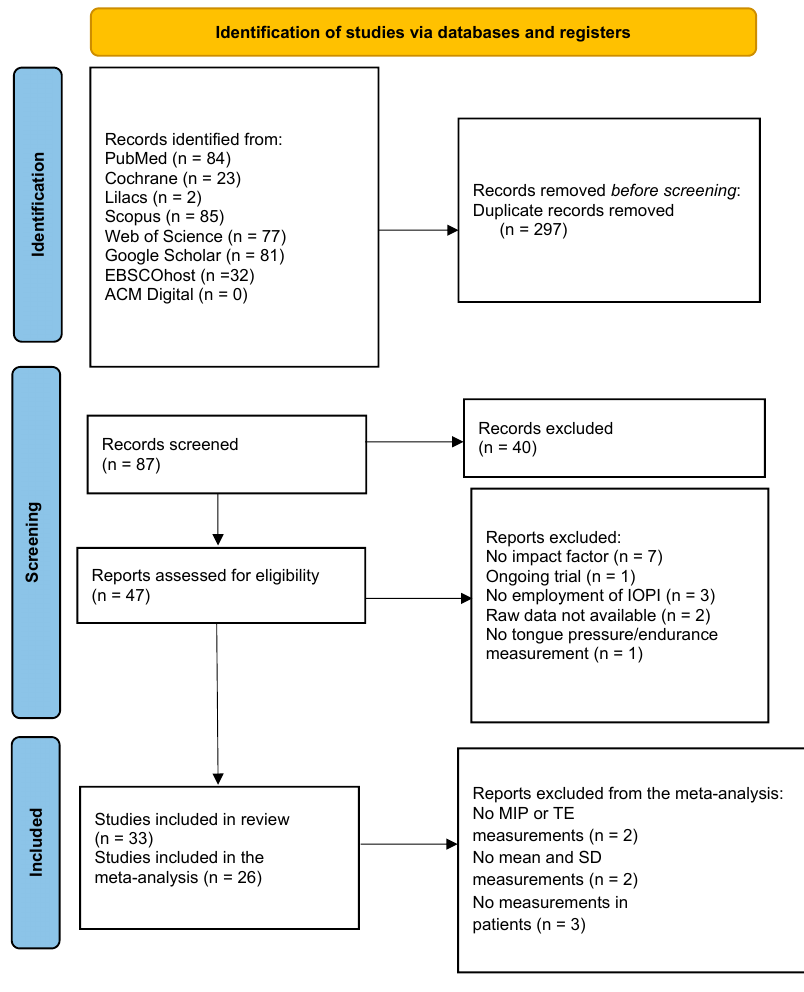
Figure 2. Flow chart of the search